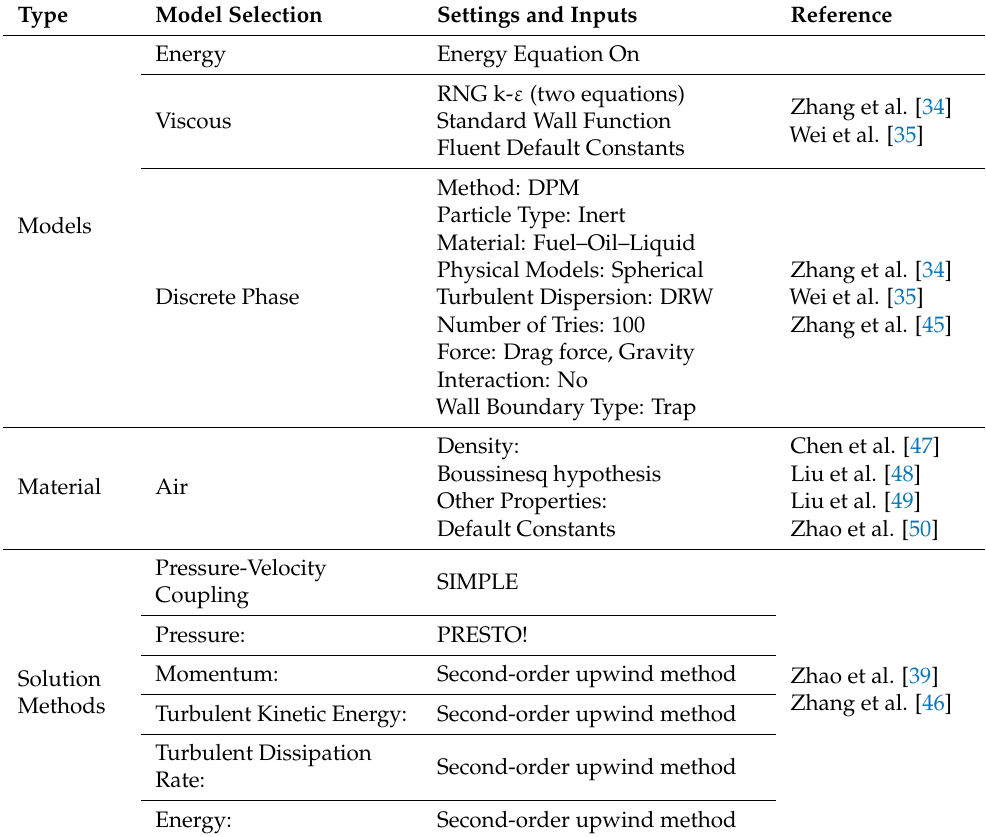
Table 1. CFD model selection, settings and